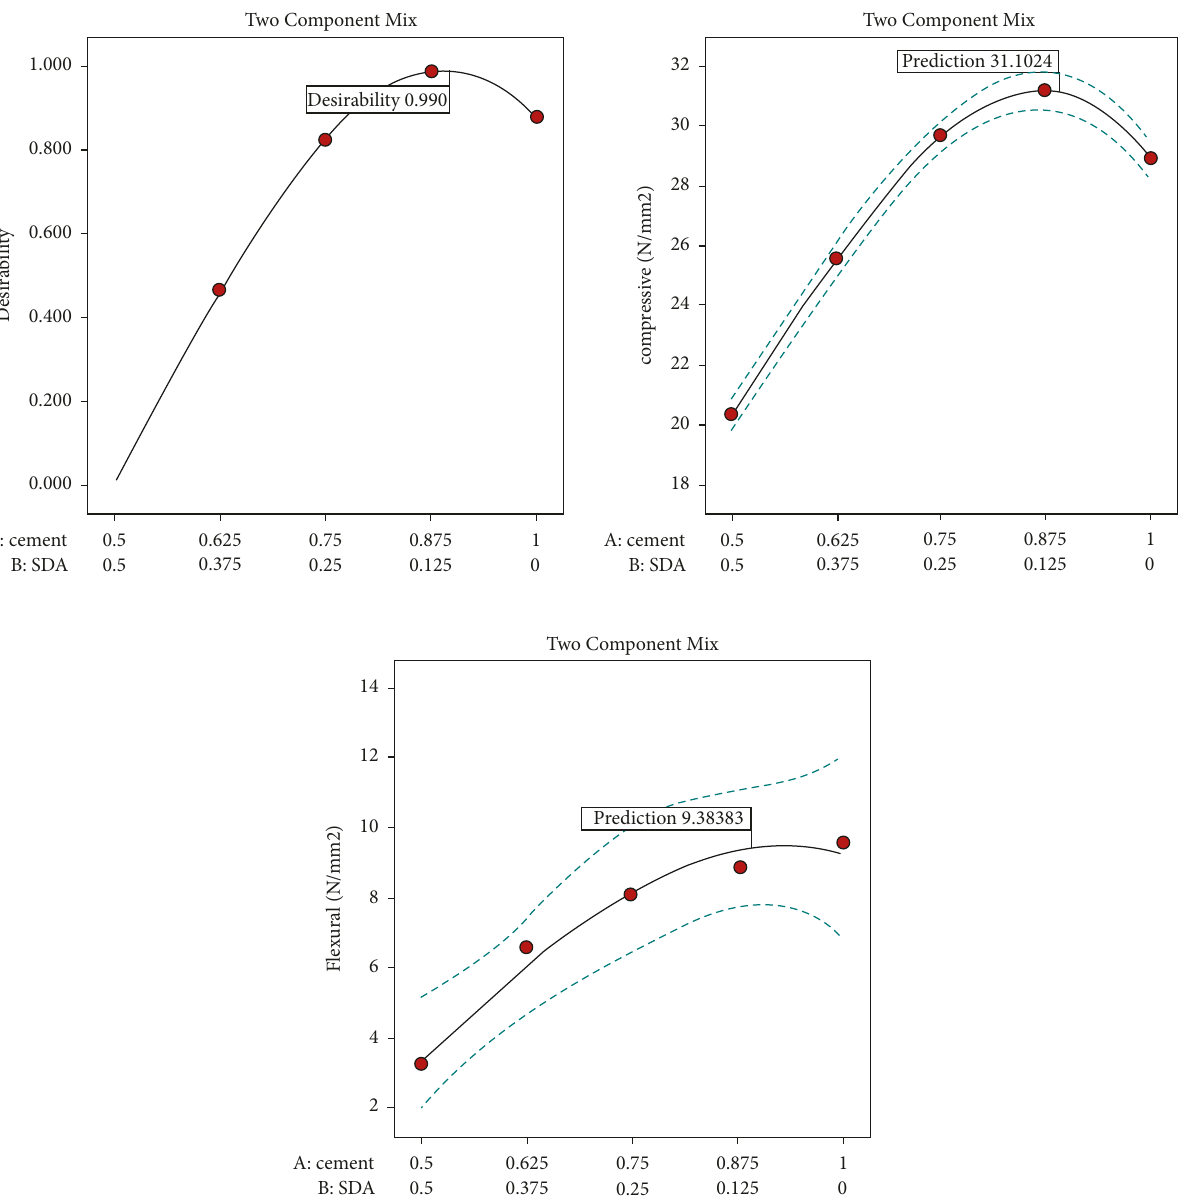
Figure 18: Graphical plot of two-component mixture